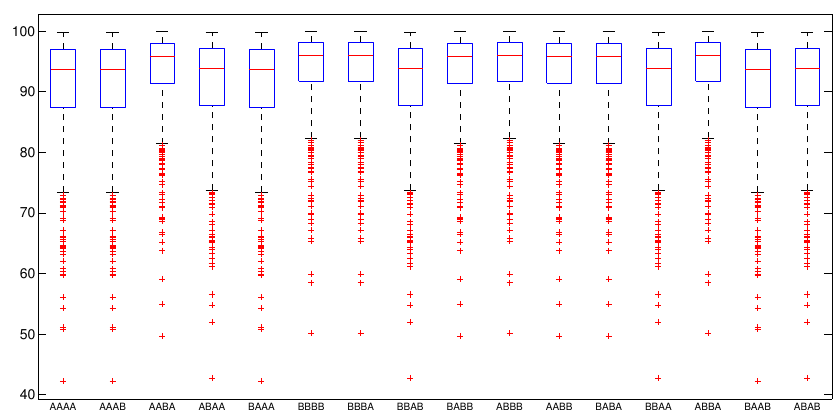
Figure 7. Box and whiskers plot showing the results of various intervention strategies on the effective reproduction number R ef f